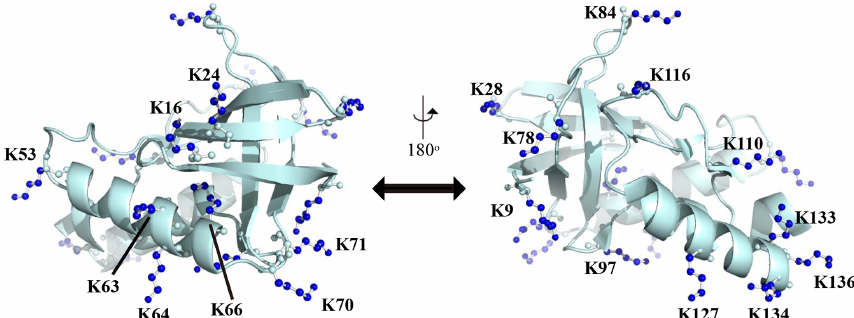
Figure A1. Distribution of the Lys residues in the crystalline structure of the (cid:49) + PHS/V66K variant of SNase (PDB#: 3HZX). All of the side-chain moieties of the Lys residues, which are shown by the ball-and-stick model in blue, exist on the protein surface, except for the Lys- 66 (K66). This engineered residue is locked in the protein interior that is originally occupied by the Val side chain in the wild-type protein. Two Lys residues, K5 and K6, were not visible in the X-ray analysis of the SNase complexed with calcium and thymidine 3 (cid:48) ,5 (cid:48) -diphosphate, and thus it may be slightly different from that in the free state. The figure was created using PyMOL 2.4 software.